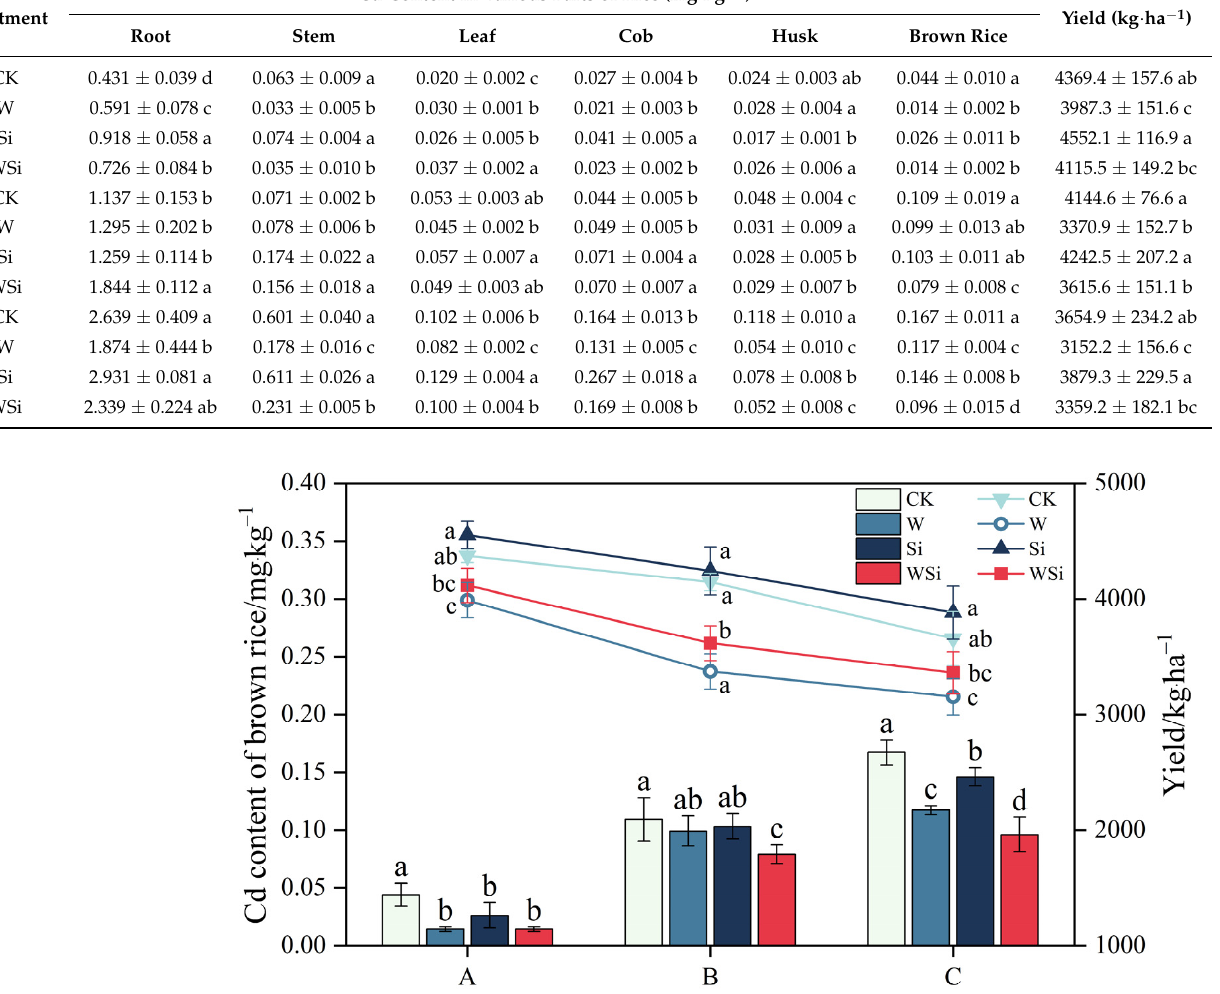
Table 1. Synergistic effects of water management and silicon foliar spraying on Cd content in rice organs and on rice yield. There is no significant difference between values with the same letters in the table ( p ≥ 0.05, Fisher’s LSD test). A, B and C represent the actual measured Cd content in soil after the addition of exogenous Cd at 0.20 mg · kg − 1 , 0.60 mg · kg − 1 and 1.60 mg · kg − 1 , respectively. Cd Content in Various Parts of Rice (mg · kg − 1 )